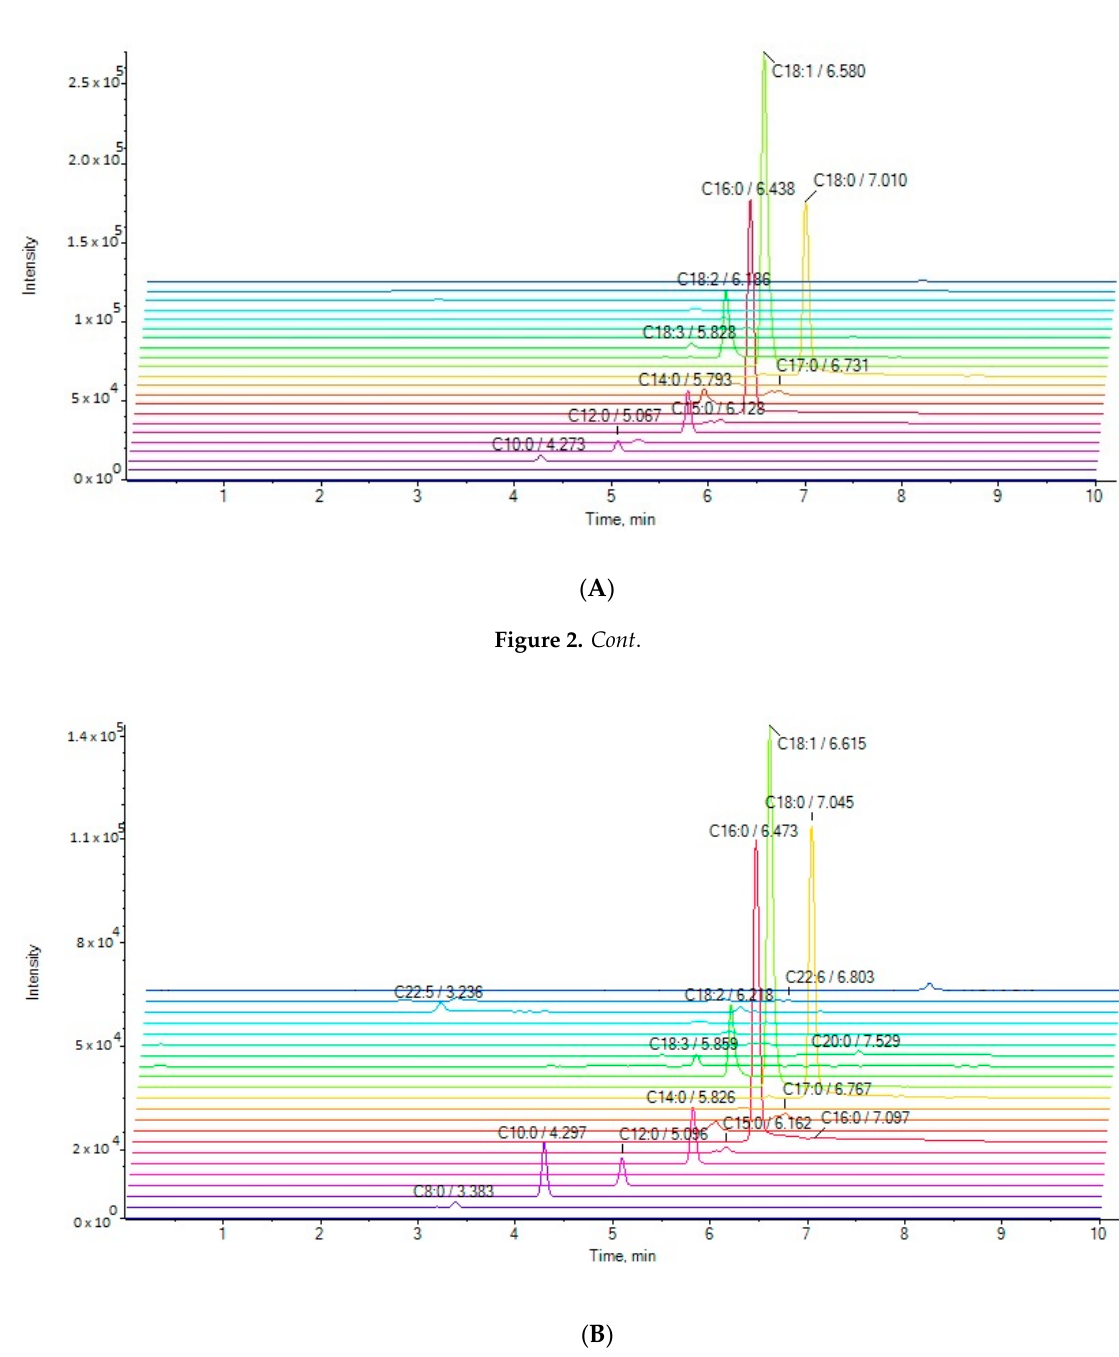
Figure 2. EICs of the analytes in a cow milk sample ( A ) and in a goat milk sample ( B ).